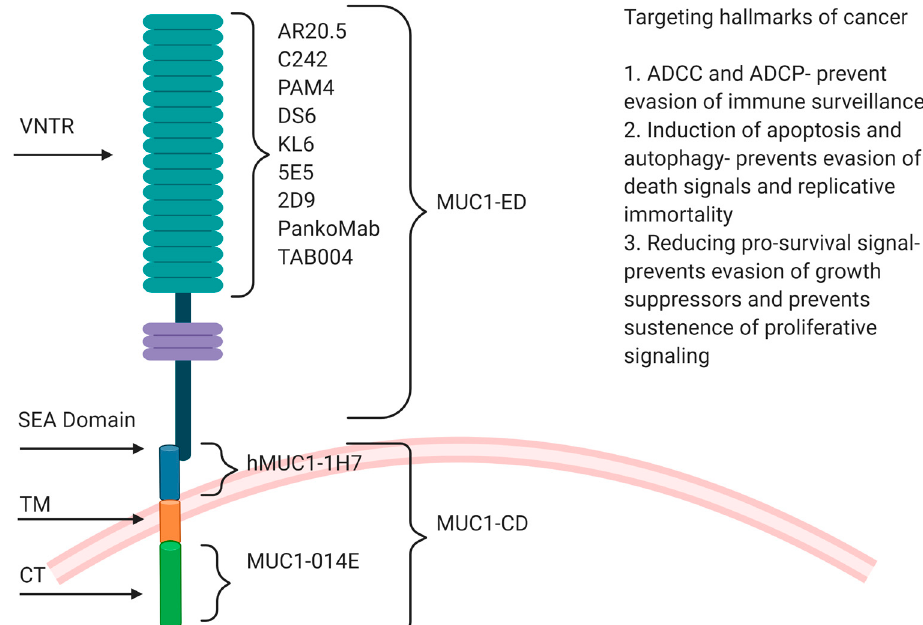
Figure 1. A schematic diagram showing the di ff erent antibodies recognizing di ff erent domains of MUC1 and also the hallmarks of cancer that they target. The various domains of MUC1 are denoted with di ff erent colors, ED and VNTR in sea green, SEA domain in blue, transmembrane domain in orange, and CT in light green.